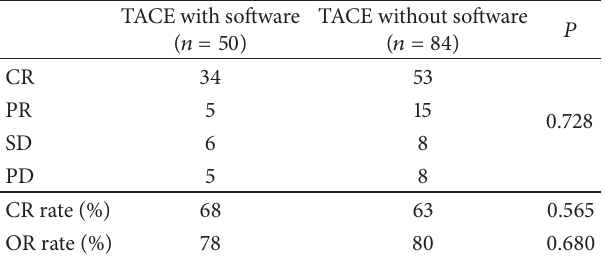
Table 4: Therapeutic efficacy of chemoembolization of hepatocellu- lar